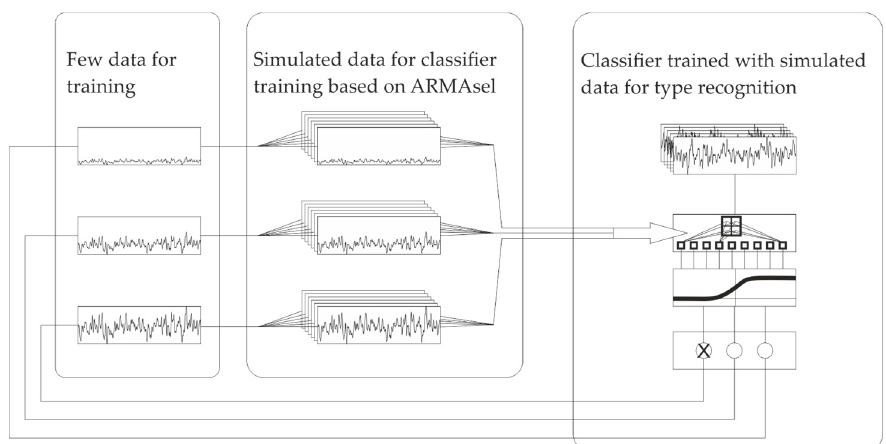
Figure 1. Illustration of the concept: Few measurement data is used for model generation, which in turn is being used for the generation of larger sets of training data. This training data is then applied to a convolutional neuronal network (CNN) for manufacturing process classification.